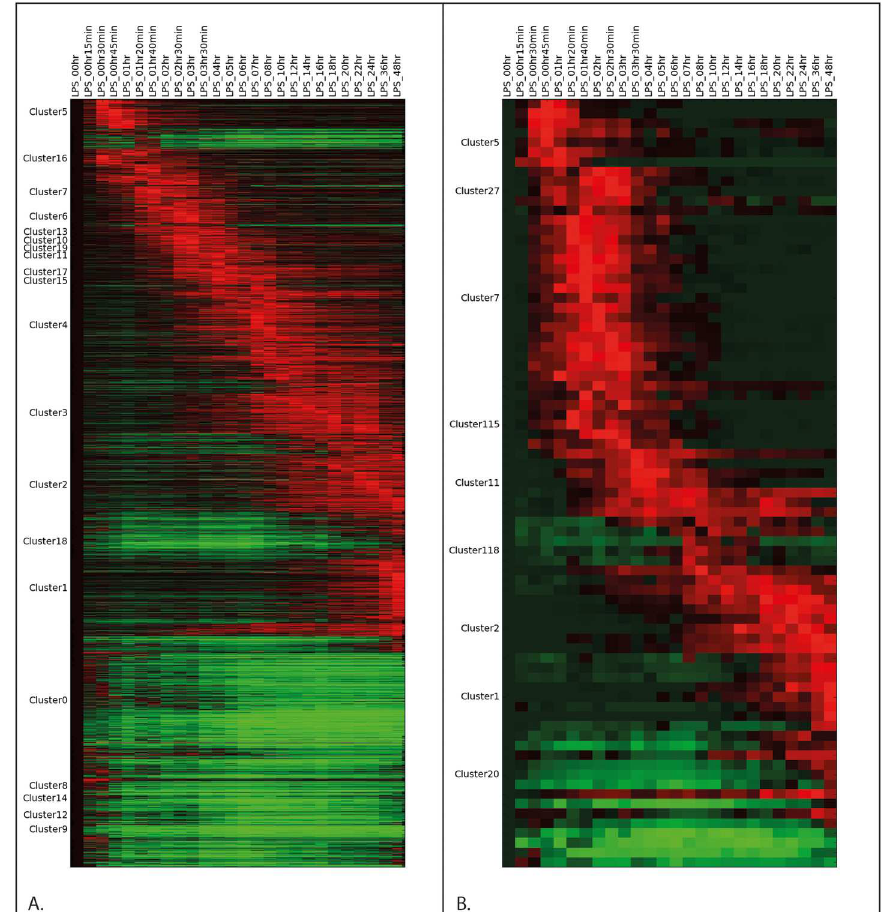
Fig 2. Transcript expressionin human macrophages exposed to LPS. Heatmapsof transcript expressionin humanmacrophagesexposedto LPS depicting changefrom baseline,normalizedto themaximumexpression of eachtranscript.Red= increase from baseline,green= decrease from baseline.Only nodesincludedin a coexpressionclusterareshownhere.(A) All clusteredtranscripts in LPS-treated humanmonocyte-derived macrophages. Clusterscontaining more than50 transcripts arelabeled.(B) Transcripts contained withinthe clustersshownin (A) that initiatenear a putativeCrohn’sdisease-associatedSNP (p < 10e-6, windowsizeto transcriptionstart site =